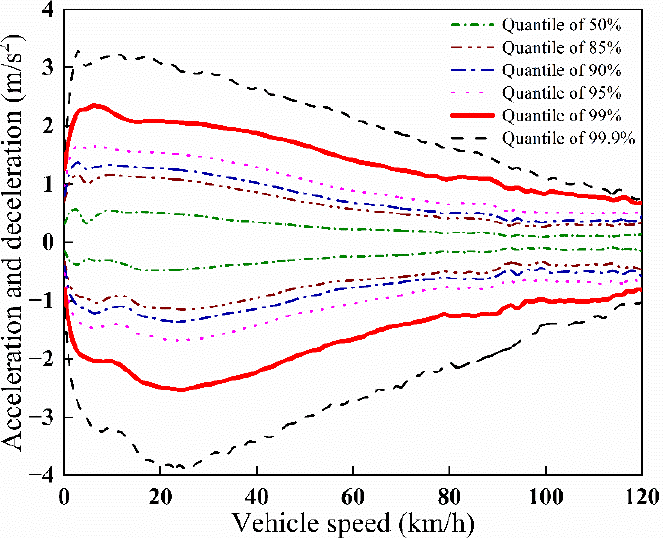
Figure 11. The comparison of different quantile value for acceleration and deceleration.